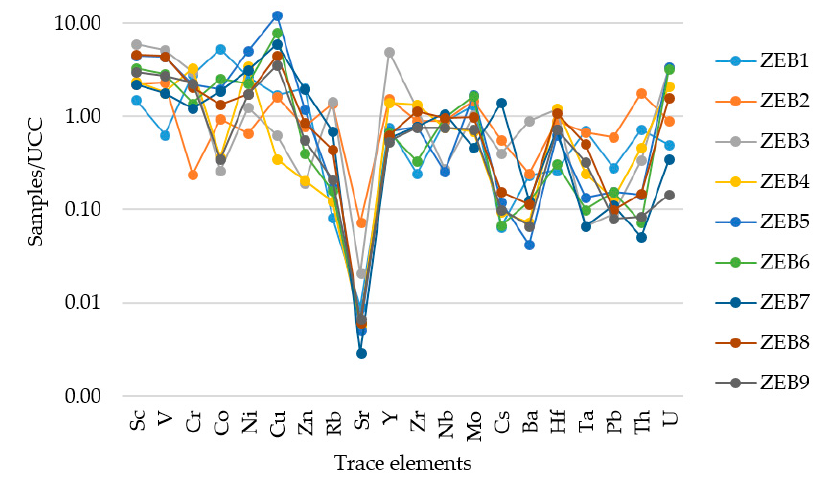
Figure 4. UCC normalised trace element concentrations of the clay size fraction of the Zebediela kaolin (arranged in increasing atomic number from Sc to U).